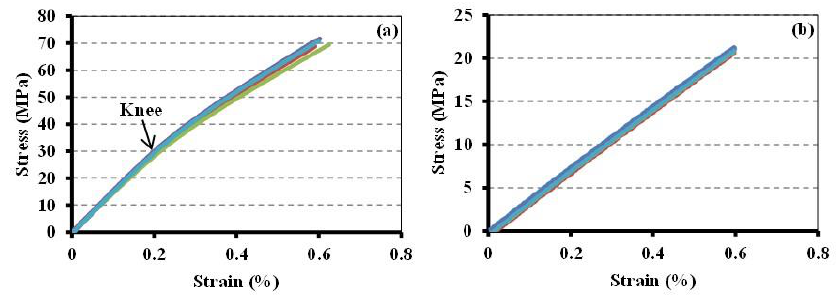
Figure 9. Tensile stress – strain curves of ( a ) unidirectional composites and ( b ) neat vinyl ester resin.